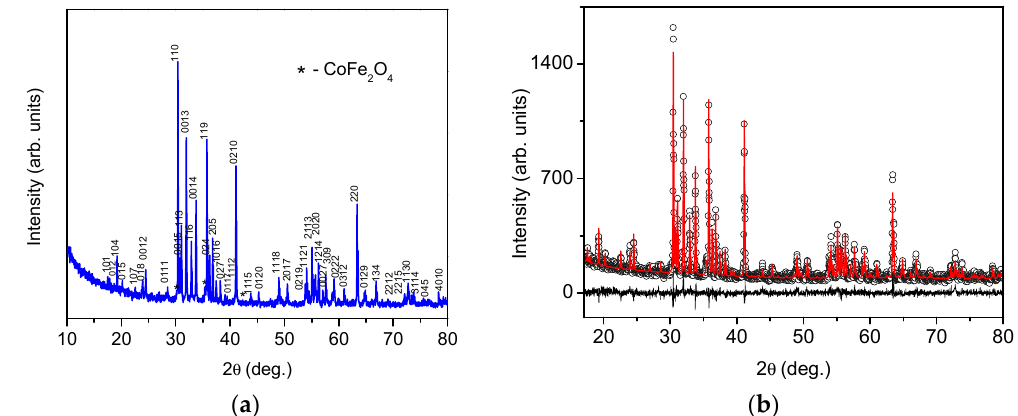
Figure 1. XRD pattern of the Ba 2 Mg 0.4 Co 1.6 Fe 12 O 22 powder ( a ) and Rietveld plot for Ba 2 Mg 0.4 Co 1.6 Fe 12 O 22 powder (black dots—experimental, red line—calculated, black line—difference) ( b ).